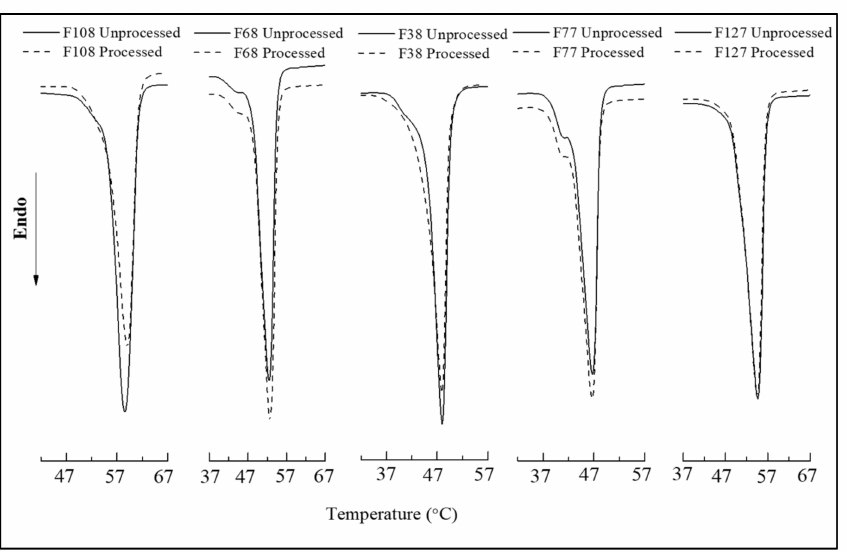
Figure 6. DSC thermograms of Pluronics before and after processing.